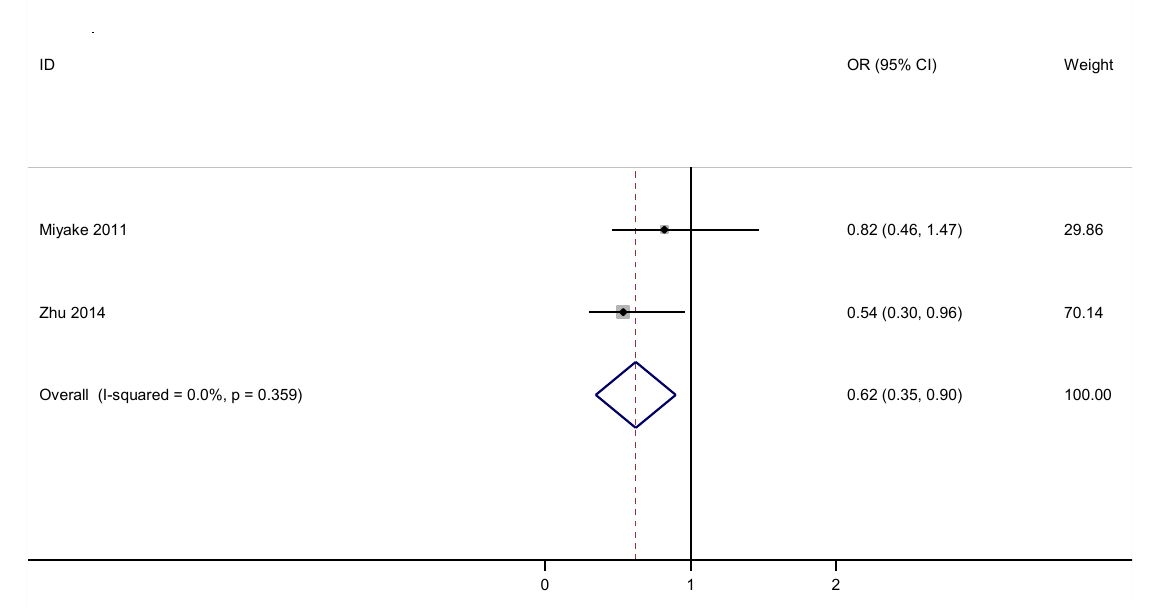
Figure 3. Forest plots of vitamin D supplementation and risk of PD.